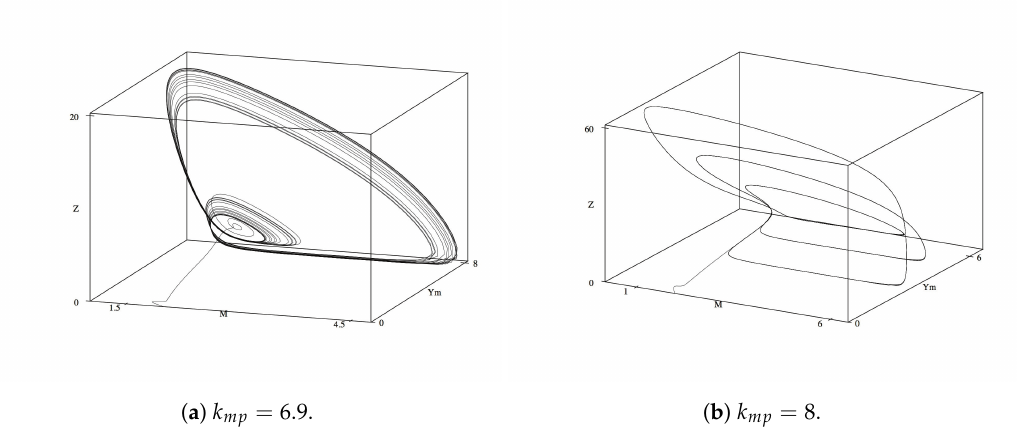
Figure 6. Phase plane diagrams for ( M , Y m , Z ) for varying k mp